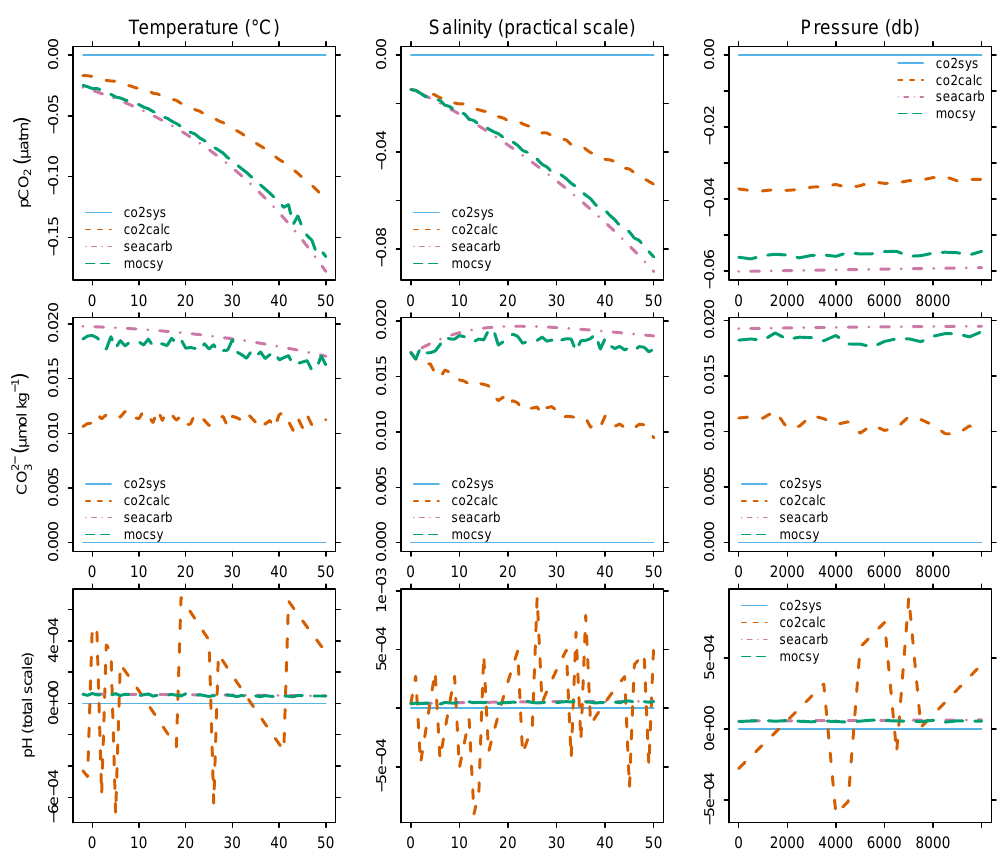
Figure 11. Effect of increased total boron on variables computed from A T and C T with each package minus results for CO2SYS-MATLAB. Shown are the effects of the increased boron (Lee et al. (2010) minus Uppström (1974)) on computed p CO 2 (top), CO 2 − pH (bottom) across ranges of T (left), S (center), and P (right). The Lee et al. (2010) formulation is included in six packages: CO2SYS- MATLAB, CO2calc, seacarb, mocsy, and both CO2SYS Excel variants. The latter two are not shown but agree with the reference. The recommendation to use the Uppström (1974) formulation by Dickson et al. (2007) came before the Lee et al. (2010) study.